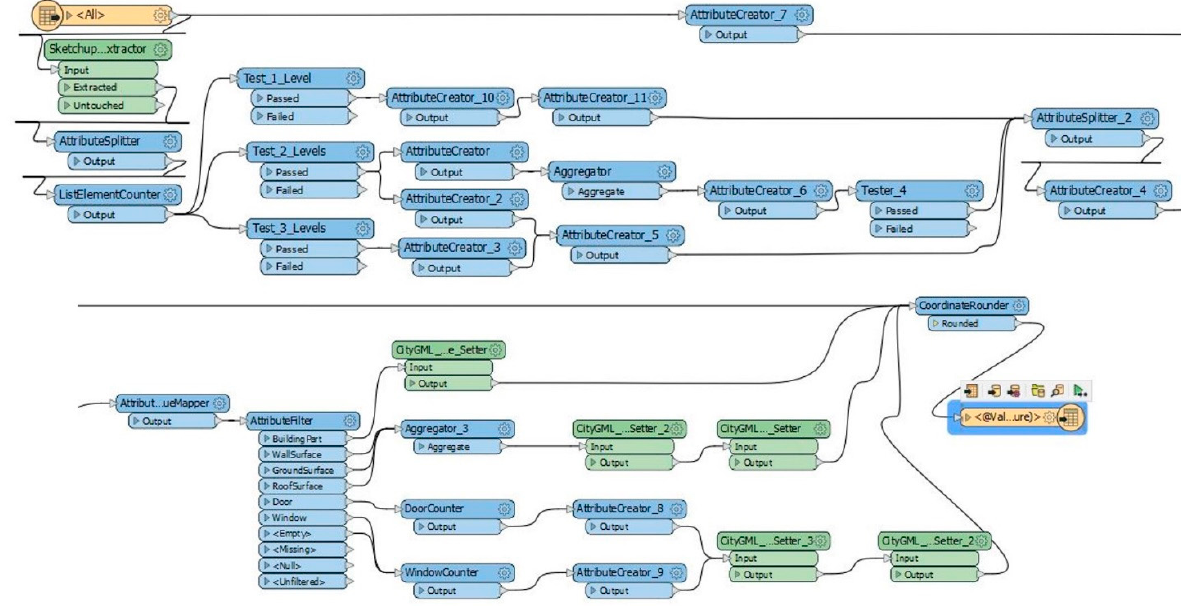
Figure 5. FME Workbench, transformation of SketchUp models into the CityGML format.